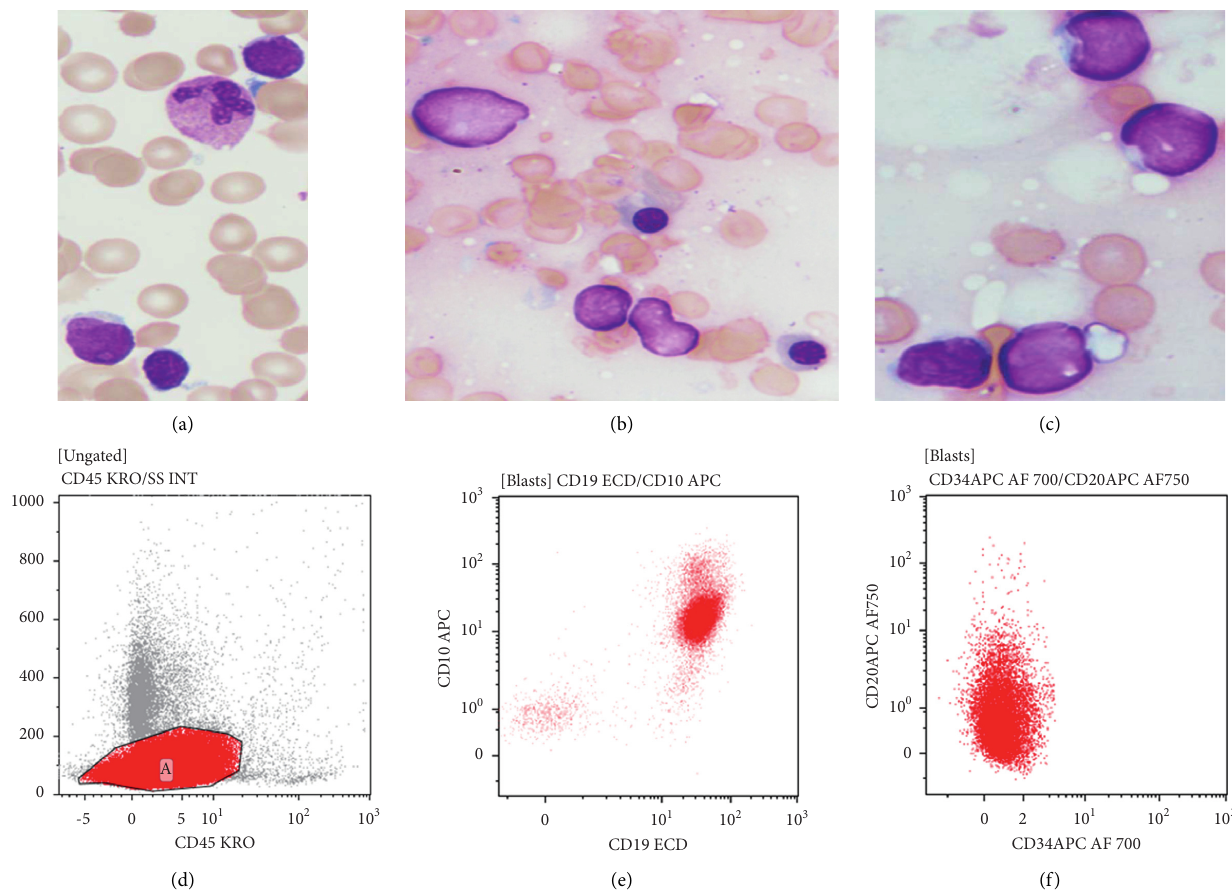
Figure 2: Lymphoblasts were rare in the peripheral blood (a) and comprised 70% of all cells in the bone marrow (b, c) (May–Gr¨un- wald–Giemsa stain, × 1000). On flow cytometry, they were CD45 negative to dim positive with low side scatter (d) and coexpressed CD19 and CD10 (e) as well as showed dim to negative CD20 expression